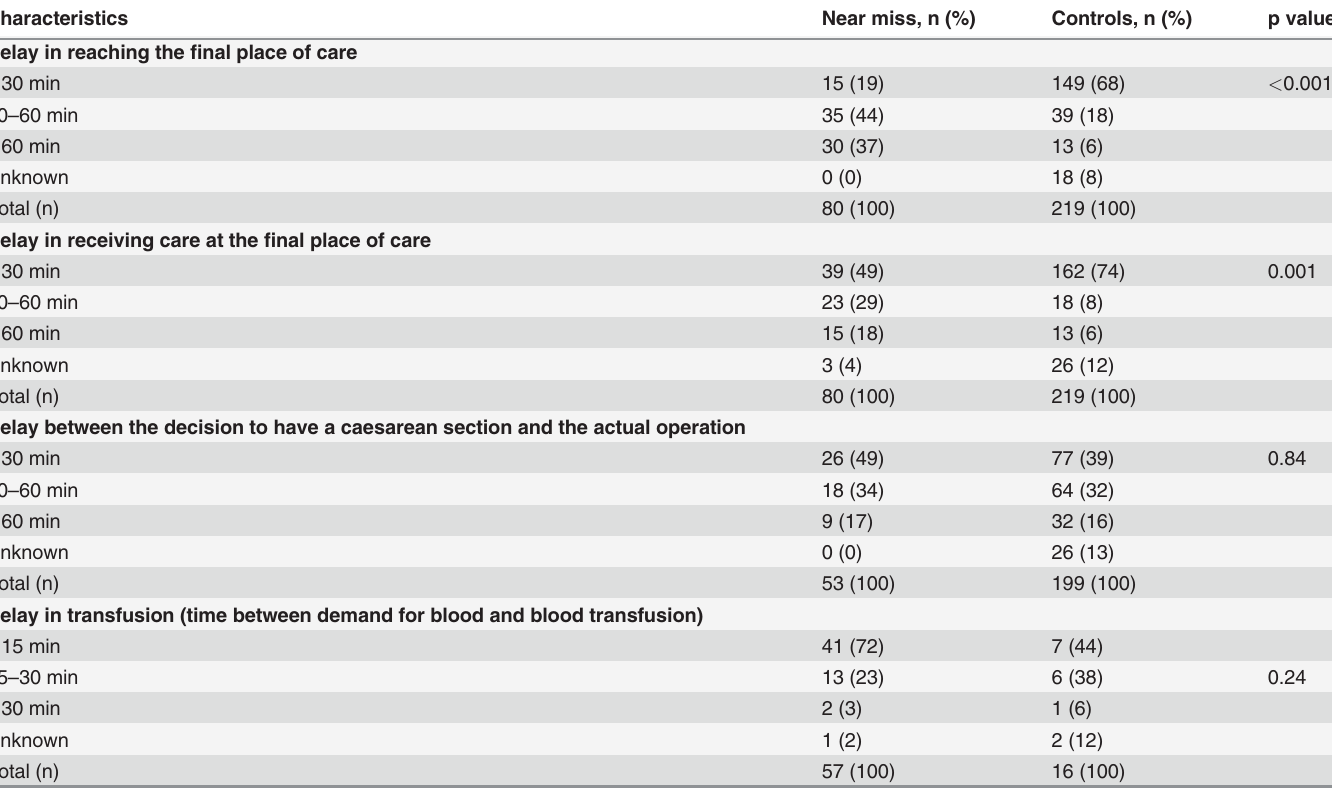
Table 4. Quality of care criteria for women in labor.